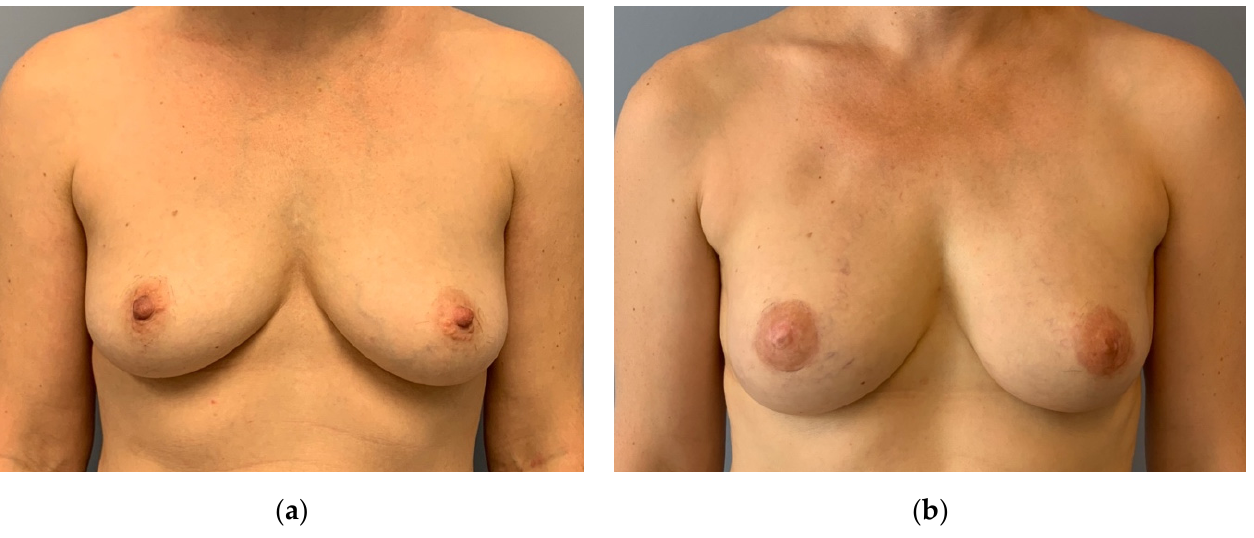
Figure 9. ( a ) Preoperative: 43-year-old patient with a mild ptosis and with BRCA 1 mutation receiving a risk-reducing mastectomy. ( b ) Four months after bilateral circumareolar mastectomy and reconstruction with DIEP flaps and free NAC grafts. No other scars evident at the breasts apart from the circumareolar.